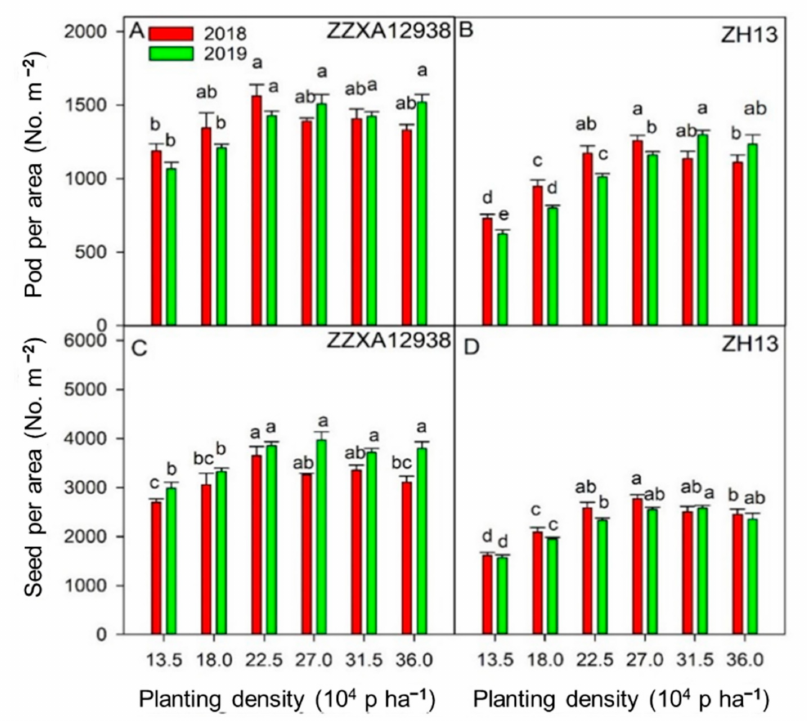
Figure 2. Pod and seed number per area as an effect of planting density and cultivar (( A , C ): ZZXA12938; ( B , D ): ZH13). Error bars represent the standard deviation of the mean. Different lowercase letters in the same year indicate significant differences among the treatments ( p ≤